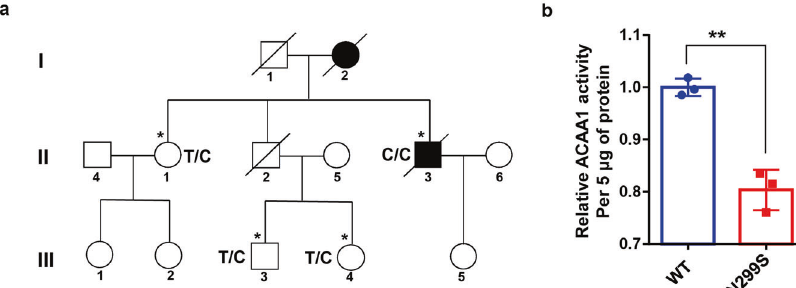
Fig. 1 The ACAA1 c.896T>C (p.N299S) variant identi fi ed in a Han Chinese pedigree with familiar AD disturbed acyltransferase activity. a Pedigree of a Han Chinese family with AD. Individuals who underwent whole-genome sequencing are indicated by asterisks (*). The subject with heterozygous or homozygous allele of rs117916664 was marked by T/C or C/C in the pedigree. b ACAA1 p.N299S protein (N299S) has reduced enzyme activity compared to the wild-type ACAA1 (WT). Puri fi ed ACAA1 p.N299S and ACAA1 WT were used for detection of acetyltransferase activity, with ACAA1 WT as the reference for normalization ( n = 3 biological replicates for each group). Results are mean ± SD. ** P < 0.01, Student ’ s t